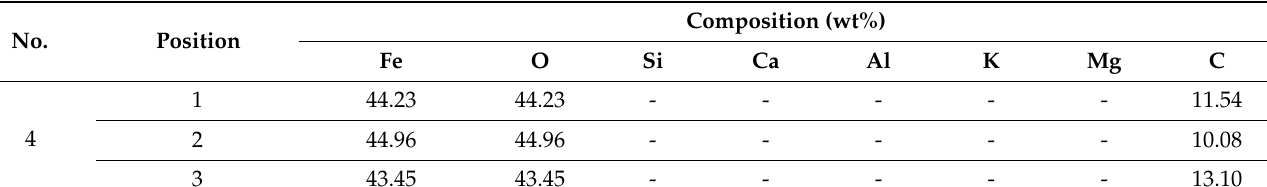
Figure 11. Microstructure and SEM image of flake hammer scale (No. 4): ( a ) whole image, ( b ) metal- lographic microscope detailed image and rectangle is position of the SEM analysisdetailed image and position of SEM analysis, ( c ) position of SEM image and EDS analysis; 1: hematite, 2: magnetite,